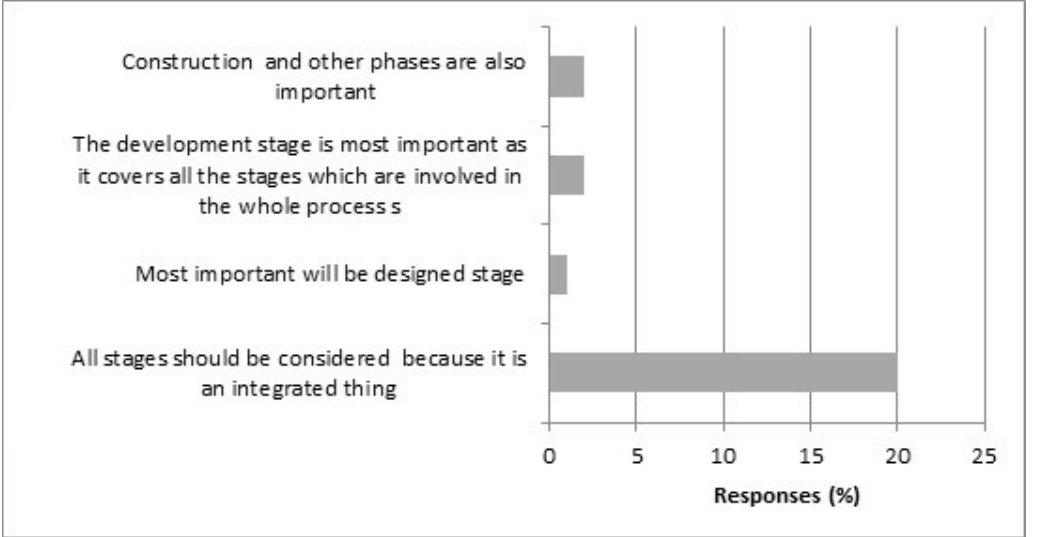
Figure 6. Important stage of the life cycle for the assessment process in the rating tool recorded in the interviews.